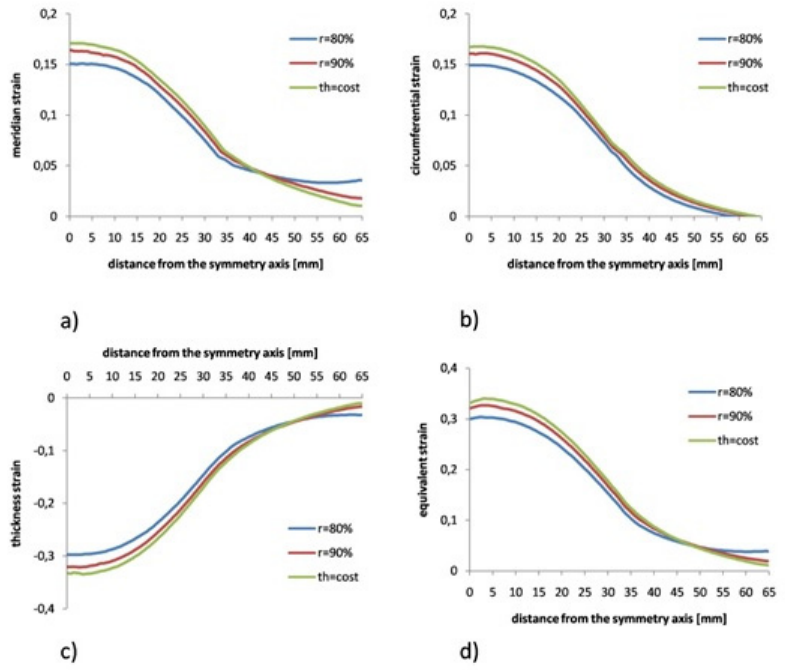
Figure 6. Comparison between the main strains and the equivalent strain during the stretching process on a constant (th = cost) and a variable (r = 80% e r = 90%) thickness sheet in perfect lubrification condition due to FEM: ( a ) meridian strain; ( b ) circumferential strain; ( c ) thickness strain; ( d ) equivalent strain.